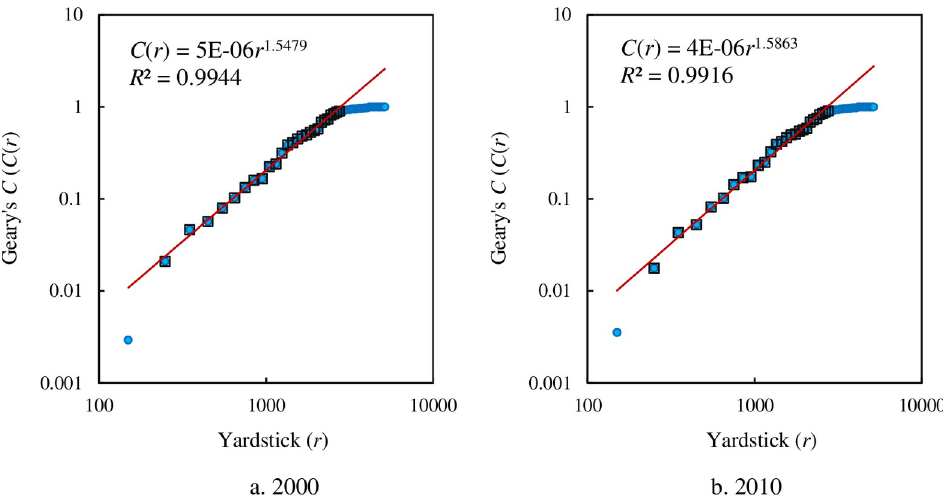
Fig 8. The scaling relations for the spatial autocorrelation function based on cumulative correlation and Geary’s coefficient. Note: The solid dots represent all points of spatial autocorrelation functions, and the hollow blocks represent the points within the scaling range. The scaling range comes between 250 and 2750 km.